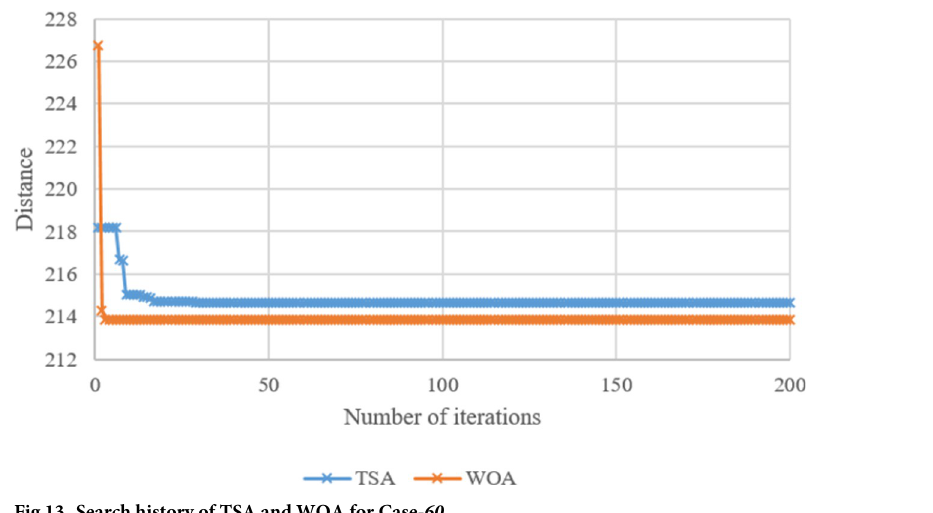
Fig 13. Search history of TSA and WOA for Case- 60